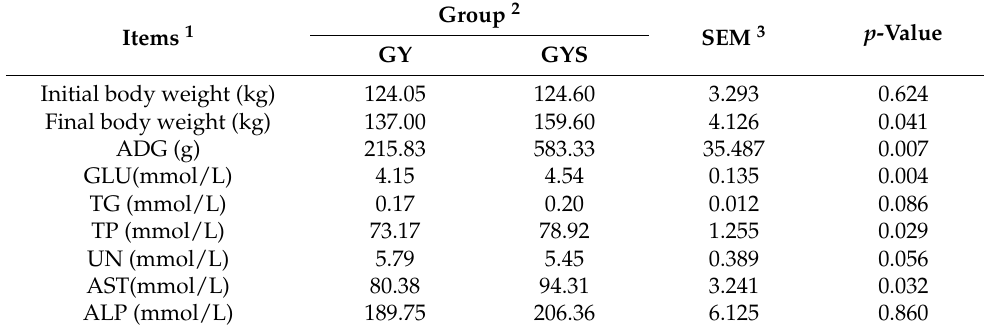
Table 2. Effect of concentrate supplementation on body weight and blood indices of grazing yaks during the warm